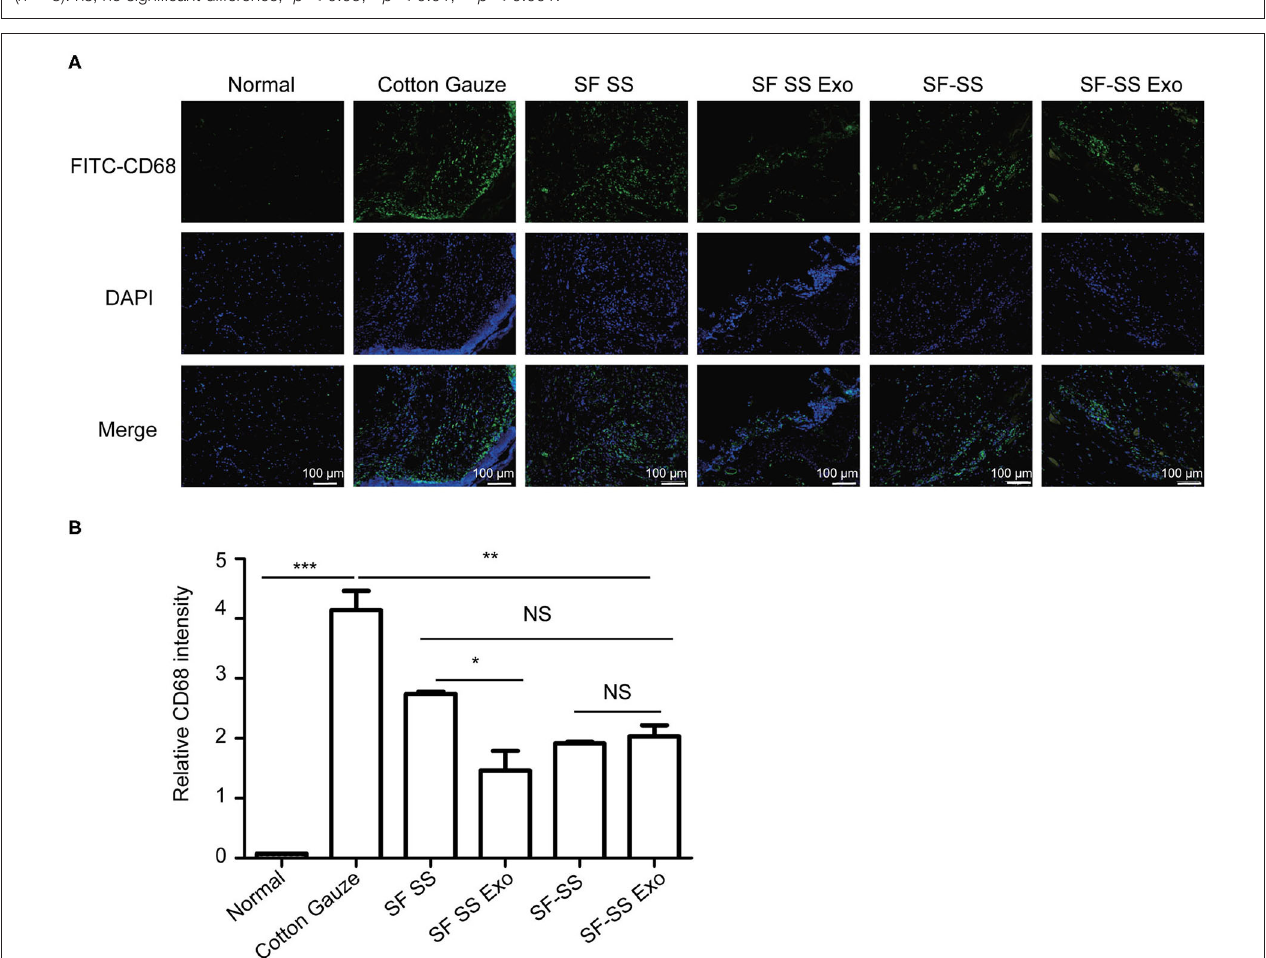
FIGURE 7 | CD68 + cells infiltration in wound treated with SF SS and SF-SS hydrogel sponges. (A) CD68 + inflammatory cell infiltration in skin wound from different treatment groups. (B) Quantification of CD68 + cells with the FITC fluorescence signal by Image J. Data is shown as mean ± standard deviation ( n = 3). ns, no significant difference, * p < 0.05, ** p < 0.01, *** p < 0.001.